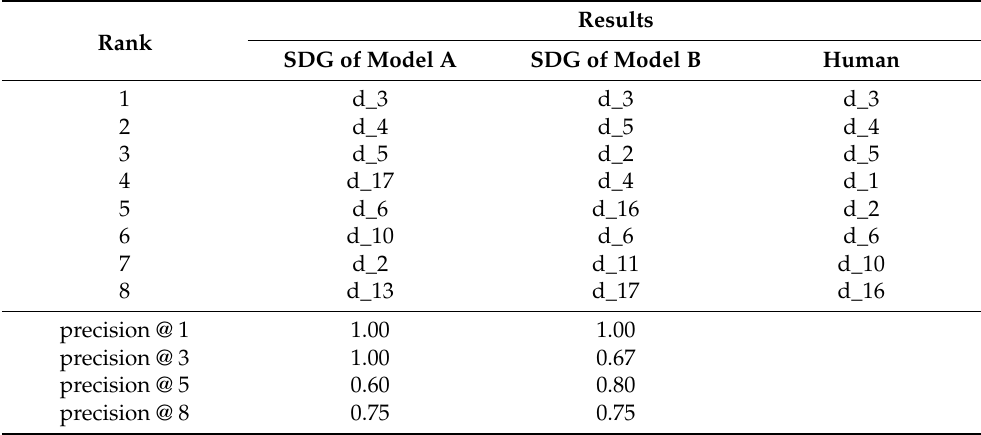
Table 1. Ranking results of Model A and Model B as well as human evaluation for low cognitive diversity case.